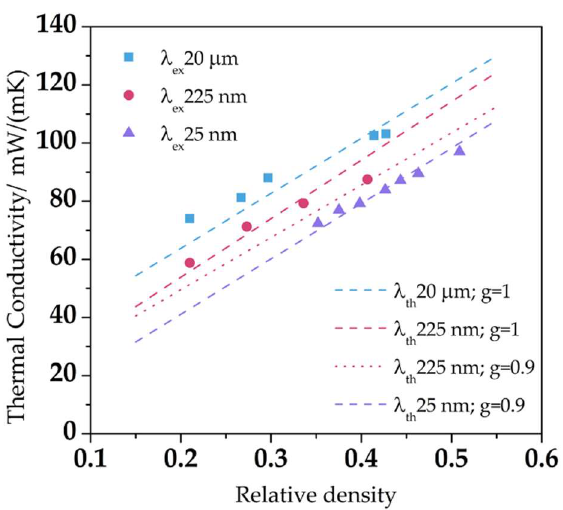
Figure 5. Experimental (points) and theoretical (dashed lines) thermal conductivities for nanocellular PMMA with different cell sizes as a function of the relative density (Adapted from reference [52]).